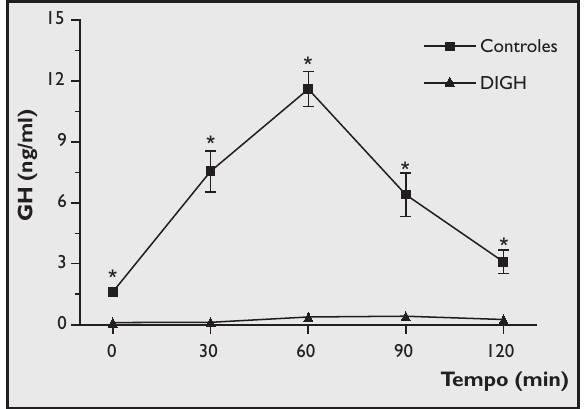
O GH é o peptídeo produzido em maior quantidade pela hipófise anterior quando comparado a outros hormônios tróficos. Sua síntese encontra-se sob o controle estimulante do GHRH e inibitório da somatostatina, exercendo no perí- odo pós-natal um papel de destaque no crescimento ósseo